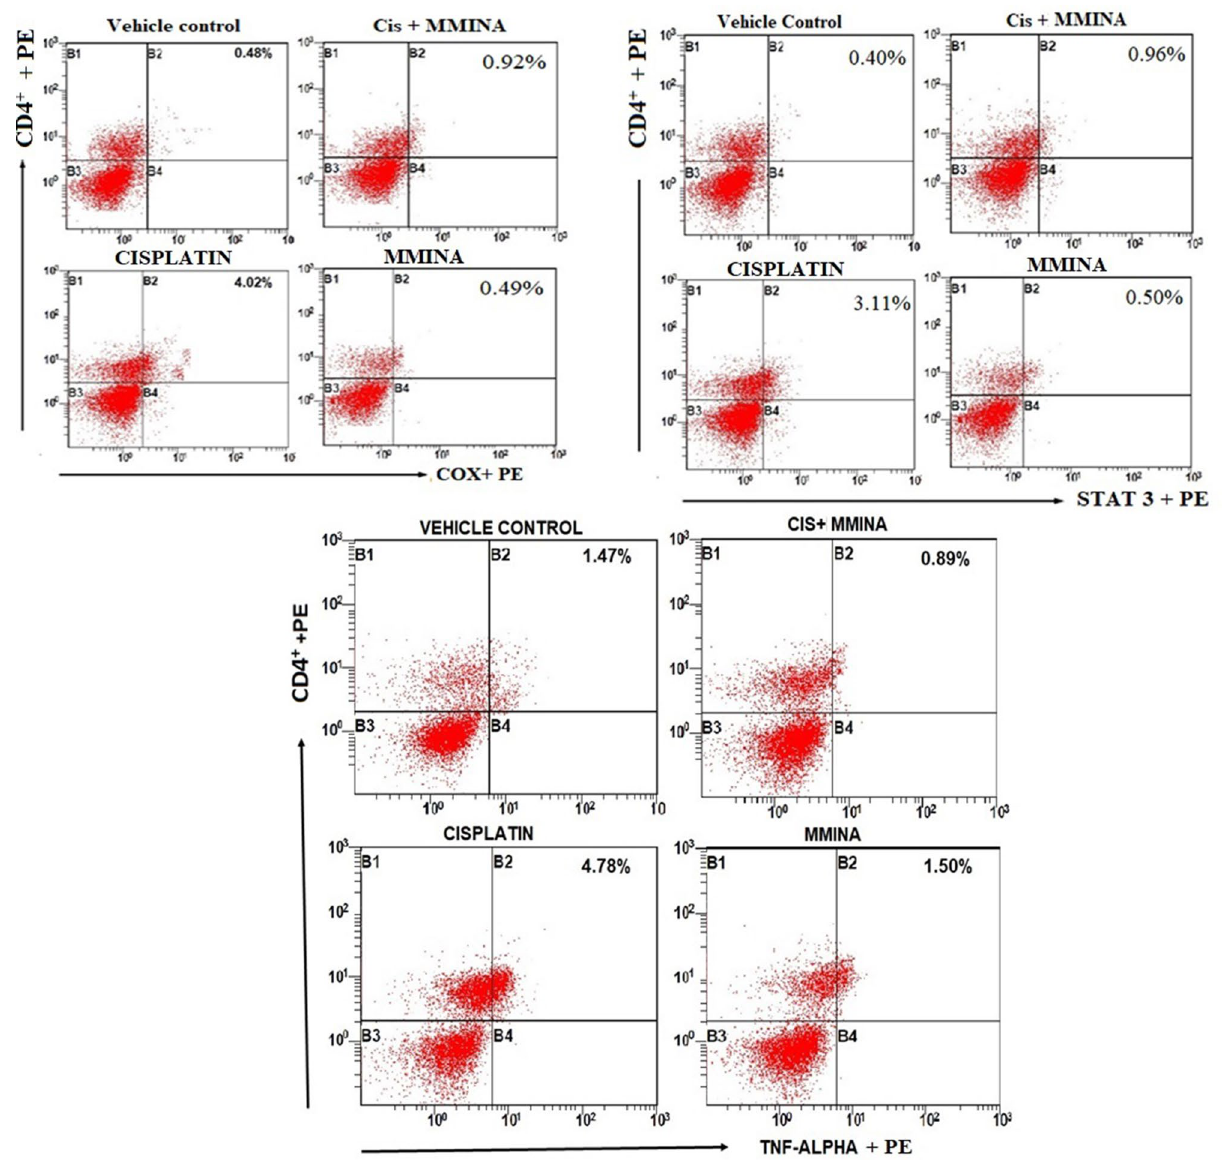
Figure 2. Effect of MMINA on CD4 + COX2, CD4 + STAT3, and CD4 + TNF-α population. Flow cytometric analysis of CD4 + COX2, STAT3, TNF-α and CD4 + expressing cells in whole bllod from one rat from each group. Statistical analysis was performed using a one way ANOVA followed by the Tukey–Kramer post-test. Each value indicates the mean ± SEM of six animals.